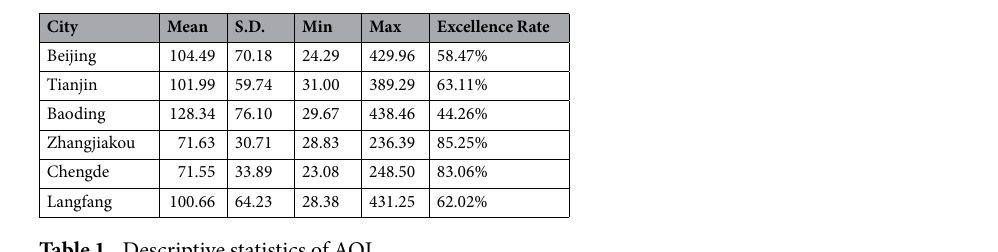
Table 1. Descriptive statistics of